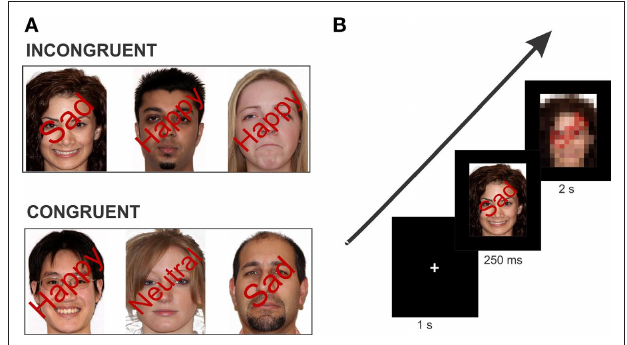
FIguRe 2 | example stimulus of each condition type and task paradigm. (A) Stimuli were isoluminant with superimposed words positioned at a 45 ° angle over the face image. In the incongruent condition, the face expression and the superimposed emotional word are conflicting. In the congruent condition, the face expression and the superimposed word describe the same emotion. Note : Stimuli here are not exact depiction of those used in the experiment. (B) Schematic overview of one trial of the experiment. The example here is an incongruent trial (face with a “Happy” expression superimposed by the word “Sad”). Each trial consisted of the fixation cross (1 s), face stimulus (250 ms), and the response image (2 s) which required the participant’s button